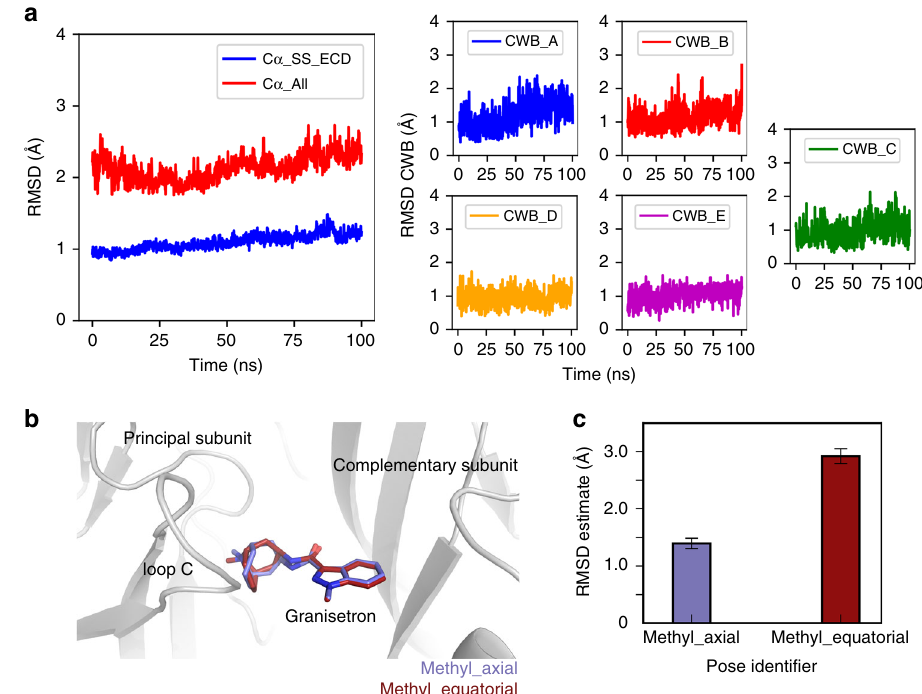
Fig. 4 Assessment of the overall stability of the granisetron-serotonin 3A receptor (5-HT 3A R) structure. a Time evolution of the root mean squared deviations (RMSD) of C α atoms of secondary structure elements of the extracellular domain (ECD) and all C α atoms of the 5-HT 3A R pentamer (left panel). The RMSD of each of the granisetron molecules (labeled CWB) in each subunit A to E (right panel) calculated with respect to the cryo-EM-derived structure during 100 ns production simulations. b Two possible granisetron poses with the bicyclic ring in boat/chair or chair/chair conformation and the N -methyl group in axial or equatorial positions in the piperidine chair conformation. These two poses were used as input for metadynamics-based ranking. c Ranking of the two granisetron poses shown in b using metadynamics. Error bars represent the standard error of the mean of RMSD estimates from 10 metadynamics simulations. Source data are provided as a Source Data fi